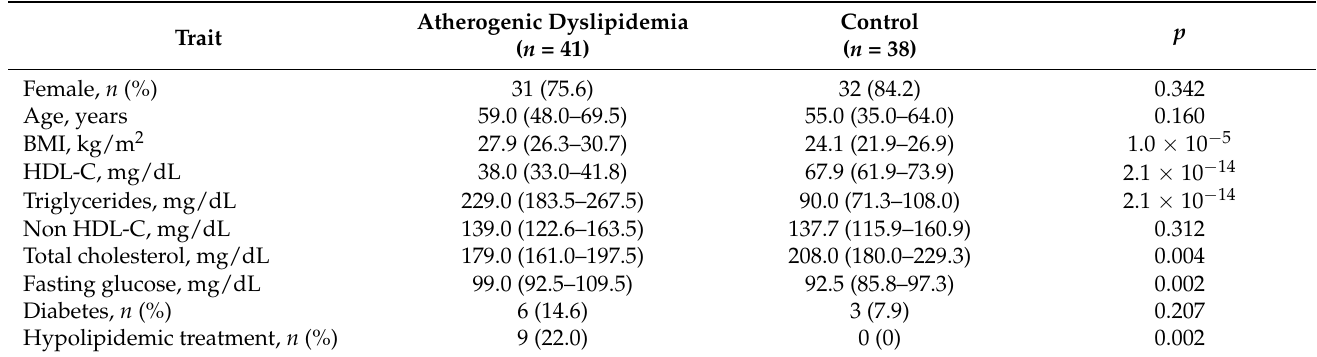
Table 1. Comparison of anthropometric and biochemical characteristics in atherogenic dyslipidemia subjects and controls.